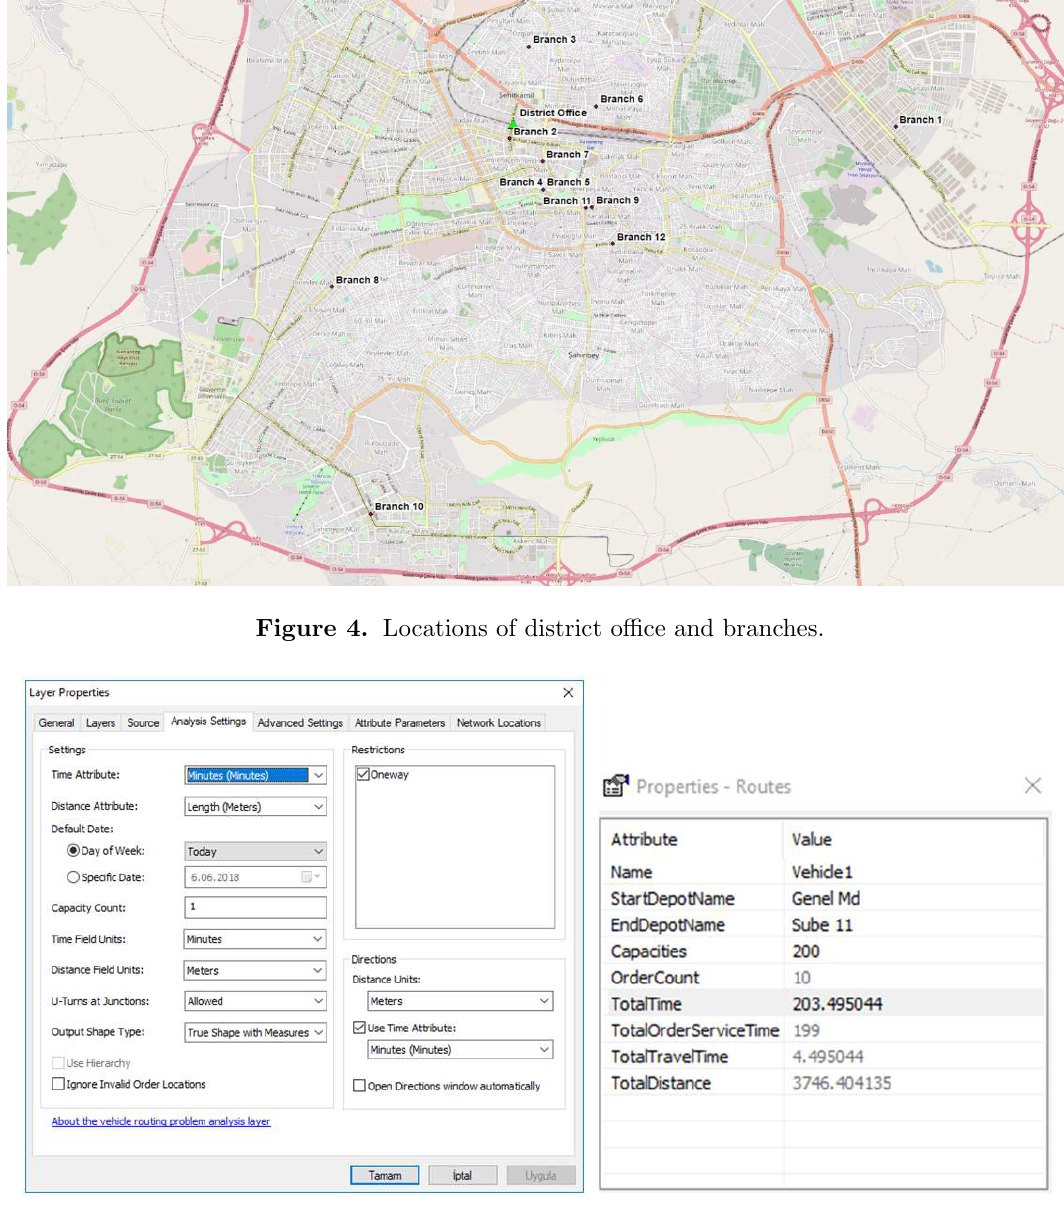
Figure 5. An example of the user interface of ArcGIS of parameter